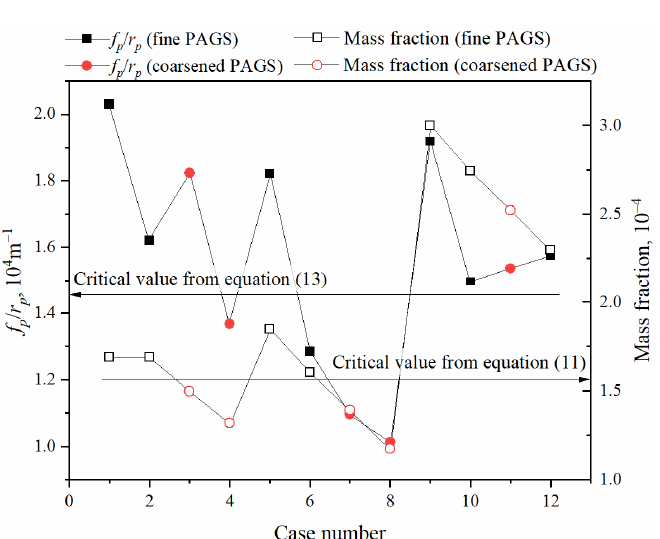
Figure 12. Calculated pinning strengths f p / r p (left, solid) and mass fractions (right, hollow) of the verified experiments. The cases are in the same sequence as in Table 4, and the black squares and red circles represent the fine and coarsened PAGSs, respectively.